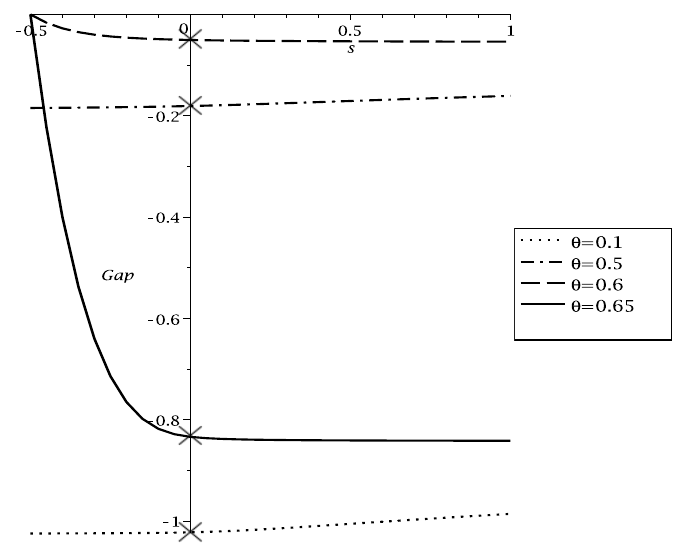
Figure 3: Spectral gap for the impurity model for L = 60, q = 3, p =